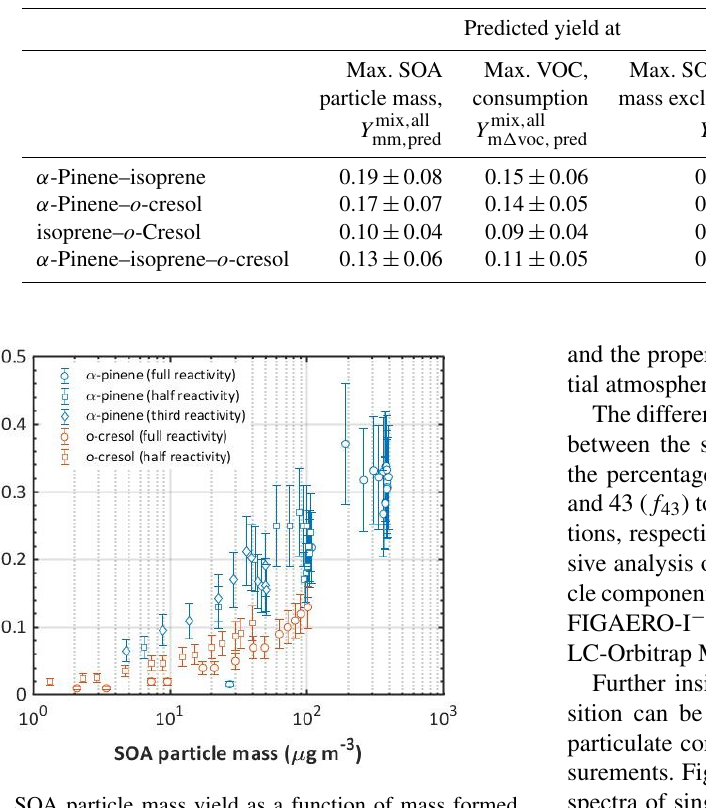
Figure 4. SOA particle mass yield as a function of mass formed in the single-precursor α -pinene and o -cresol experiments at all ini- tial concentrations. Each curve is comprised of multiple data points measured over the duration of each experiment. Error bars represent the propagated uncertainties in all measurements and in the particle wall loss corrections